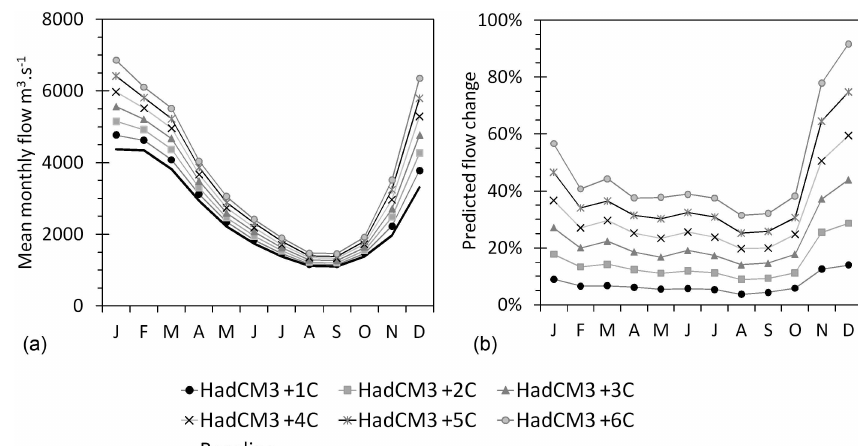
Fig. 5. Projected changes in mean monthly river flow under prescribed increases in global mean air temperature using HadCM3 in the Rio Grande basin (a) and relative to the detrended 1961–1990 baseline or control run (b) .